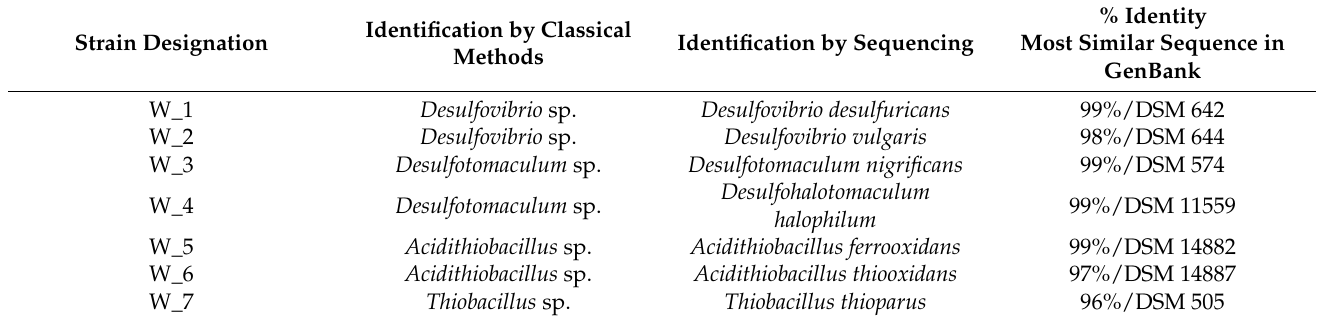
Table 5. Species status of microorganism strains.